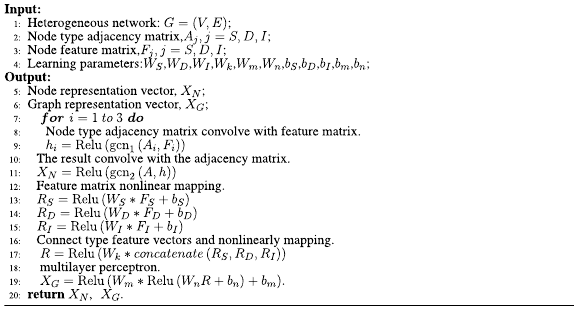
Algorithm 1. Heterogeneous network encoding.